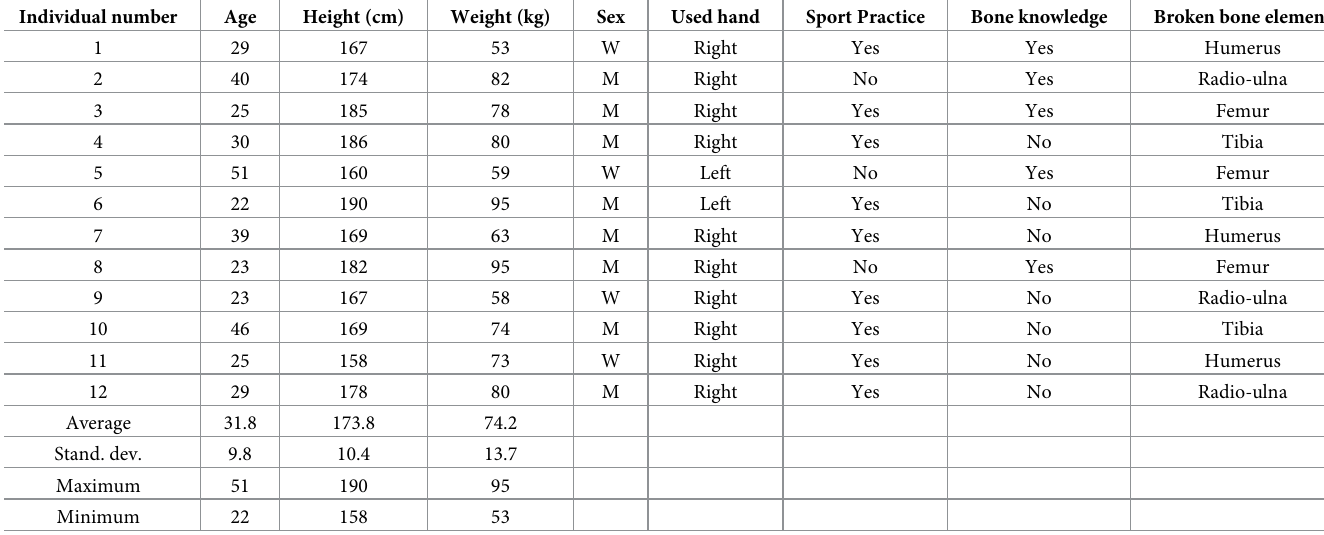
Table 2. Data about the individuals for each